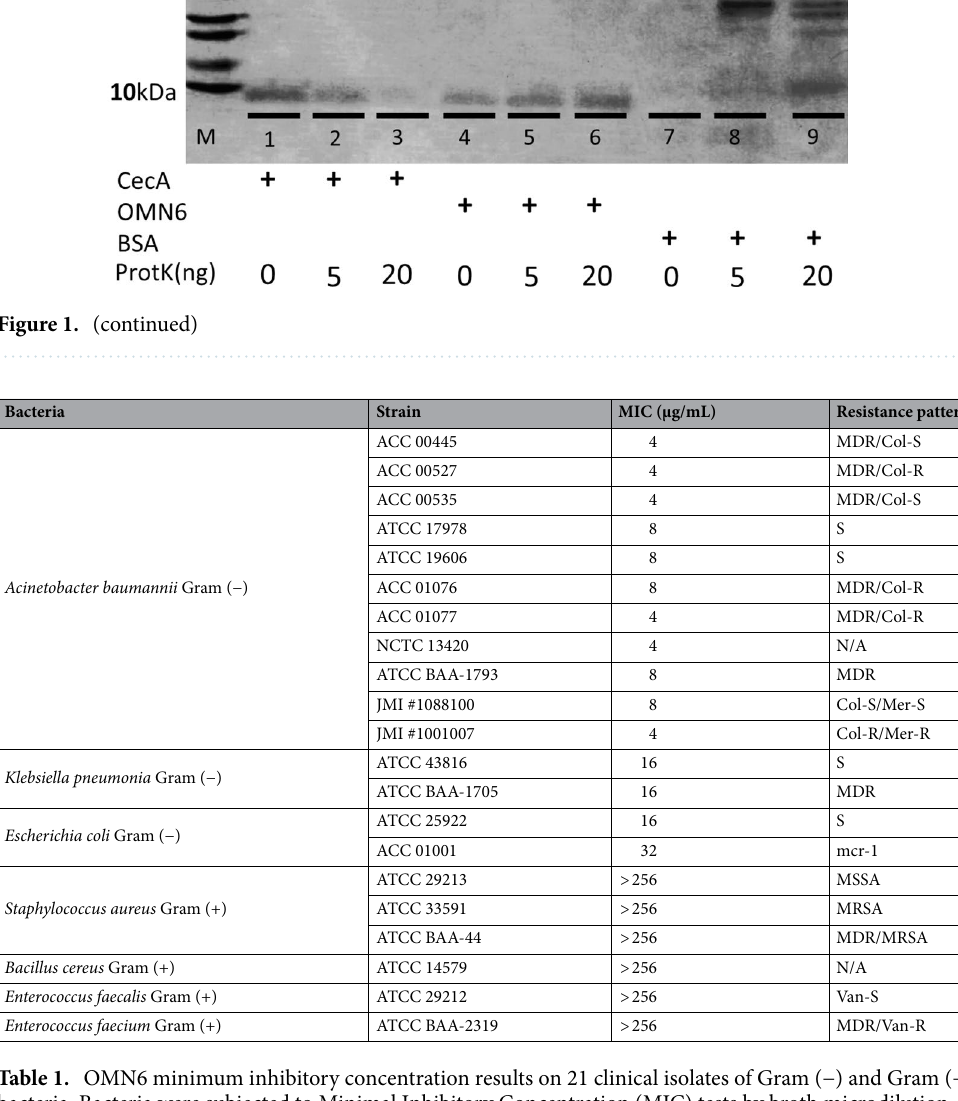
Table 1. OMN6 minimum inhibitory concentration results on 21 clinical isolates of Gram (−) and Gram (+) bacteria. Bacteria were subjected to Minimal Inhibitory Concentration (MIC) tests by broth microdilution method (CLSI guidelines). Resistance pattern of the different isolates is presented in the last column according to the following abbreviations: MDR multidrug resistant, Col-S colistin-sensitive, Col-R colistin-resistant, Mer-S meropenem sensitive, Mer-R meropenem resistant, S sensitive, mcr-1 mobilized colistin resistance gene 1, MSSA methicillin-sensitive Staphylococcus aureus , MRSA methicillin-resistant Staphylococcus aureus , Van-S vancomycin sensitive, Van-R vancomycin resistant, N/A data not available. Supplementary information about the resistance pattern of most bacterial strains used in this study is displayed in Tables S1 and